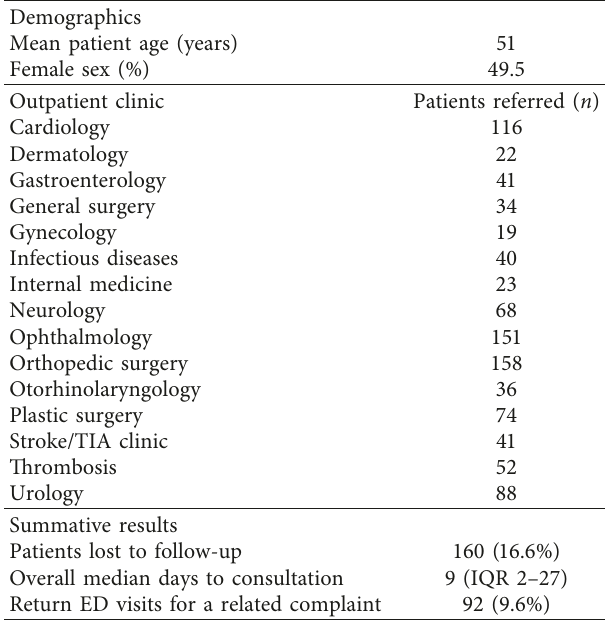
Figure 1: Flow chart of patients discharged from the ED with outpatient consultations. Table 1: Patient characteristics and summative results ( N �